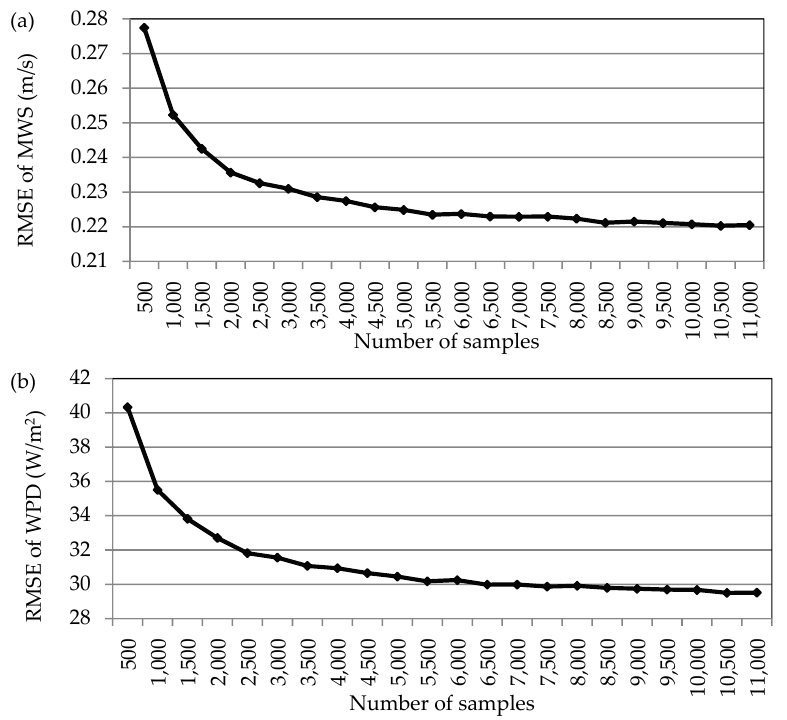
Figure 2. The mean RMSE of MWS and WPD from random sampling of all satellite observations (QuikSCAT + WindSAT + ASCAT) with different numbers of samples compared to the buoy-derived MWS and WPD at a height of 10 m above sea level. ( a ) MWS, and ( b ) WPD.